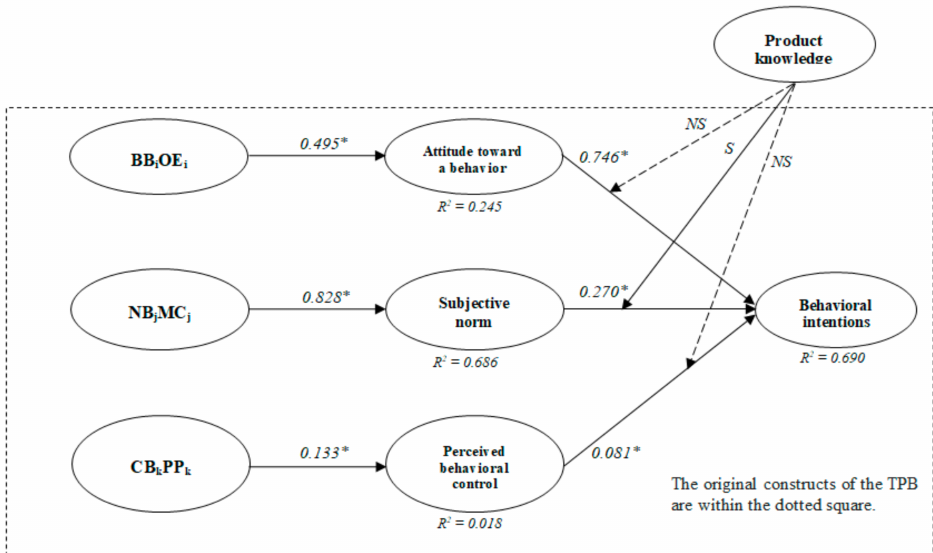
Figure 2. Results of structural equation modeling. Notes 1: BB = behavioral beliefs, OE = out- come evaluation, NB = normative beliefs, MC = motivation to comply, CB = control beliefs, and